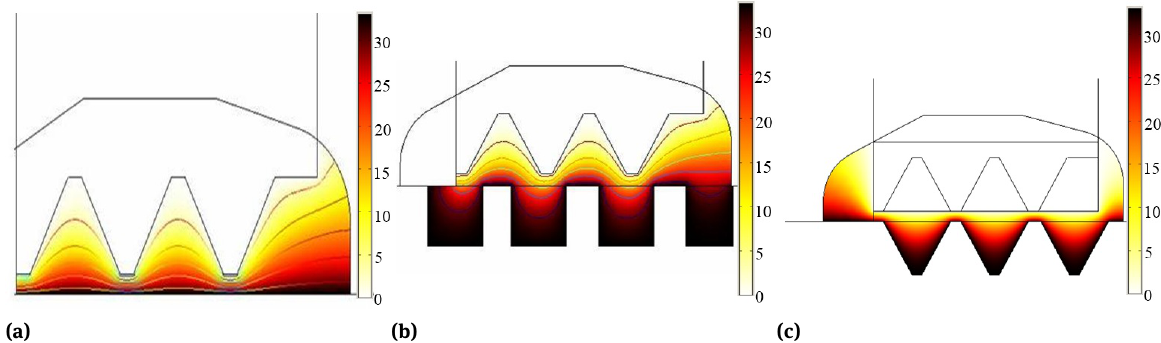
Figure 3: The distribution of azimuth component of the velocity of magnetic fluid flux in the gap of the magnetic system at the surface ve- locity ν for: a) – the sealer of classical design; b) – with teeth on the magnetic circuit of trapezoidal form and “inner” teeth of ^ I = 33 i /˜ n rectangular form on the shaft; c) – with “inner” teeth of trapezoidal form on the